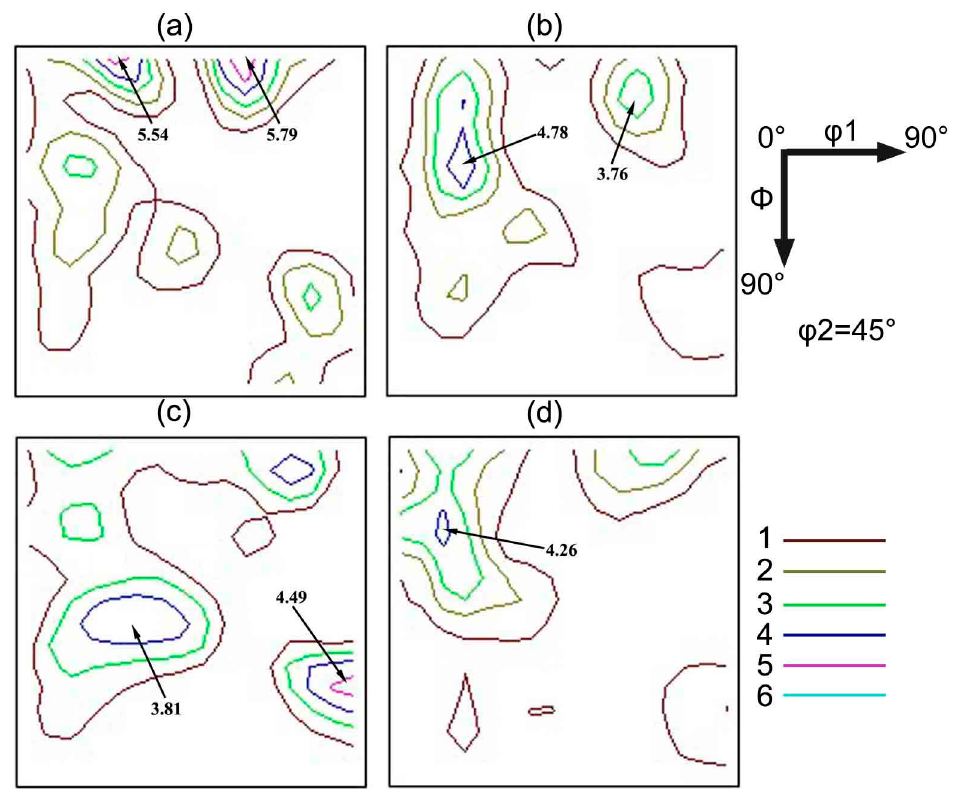
Figure 7. ODFs at φ 2 = 45° of primary recrystallized sheet: ( a ) Nb-free, ( b ) Nb-0.005 wt%, ( c ) Nb-0.009 Figure 7. ODFs at ϕ 2 = 45 ◦ of primary recrystallized sheet: ( a ) Nb-free, ( b ) Nb-0.005 wt%, wt%, ( d ) Nb-0.025 wt%. ( c ) Nb-0.009 wt%, ( d ) Nb-0.025